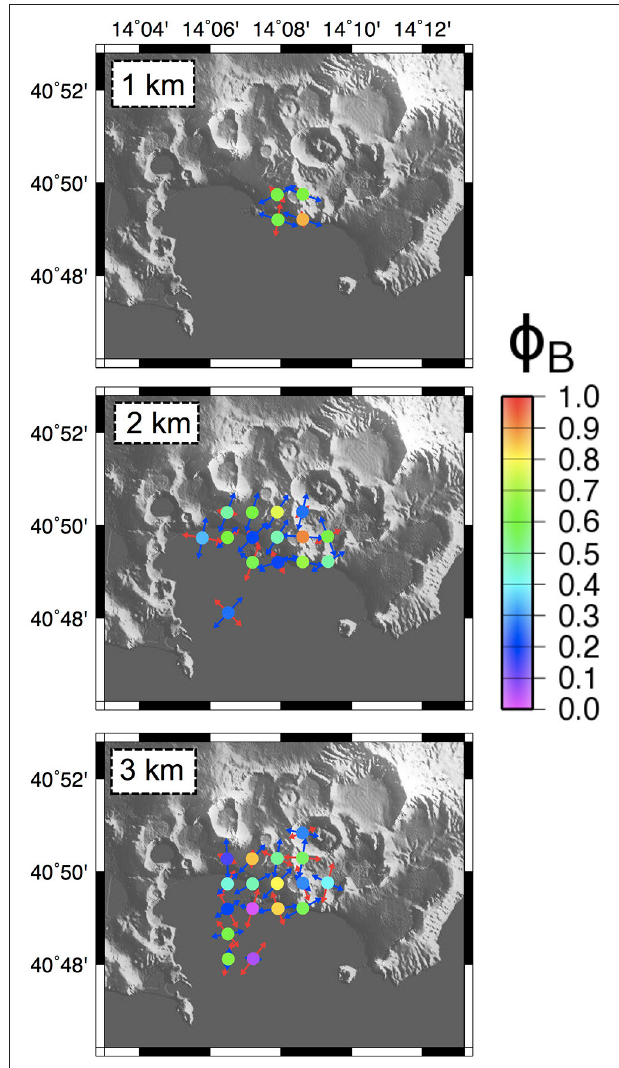
FIGURE 8 | Campi Flegrei. Stress field tensors retrieved from focal mechanisms data using the BRTM. Slices at 1, 2, and 3 km-depth. Stress tensors have been computed over a regular grid of 1-km spacing, considering only nodes containing at least five FPSs. σ 1 and σ 3 axes are plotted as pairs of respectively red-blue arrows. The color of the circles corresponds to the retrieved 8 B value for each node (see scale on the